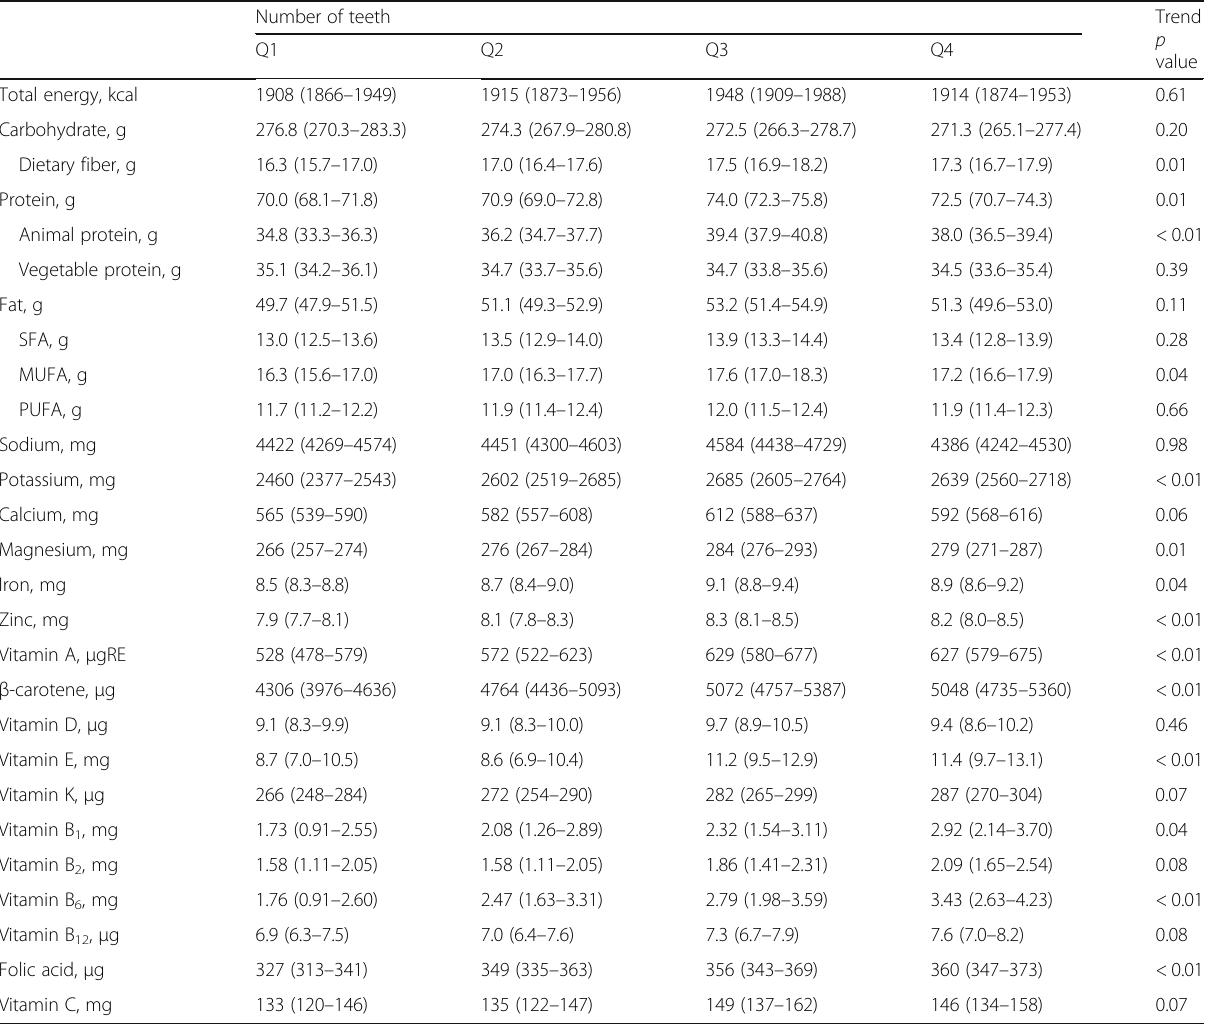
Table 3 Adjusted means of nutrient intake by the number of teeth (brackets contain 95% confidence intervals) Number of teeth